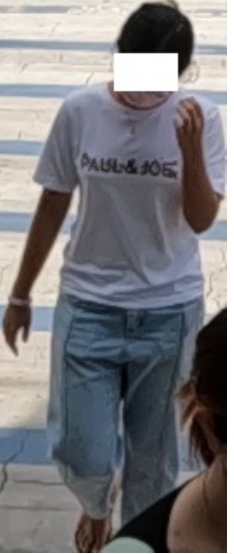
Figure 8. An image of the person to search for that our system was unable to find. The challenge for this particular case is that a white t-shirt and jeans is a popular choice of clothes, and the description is short because the person does not have any other distinctive features. The system was able to discover people that generally fit the description but was unable to find this particular